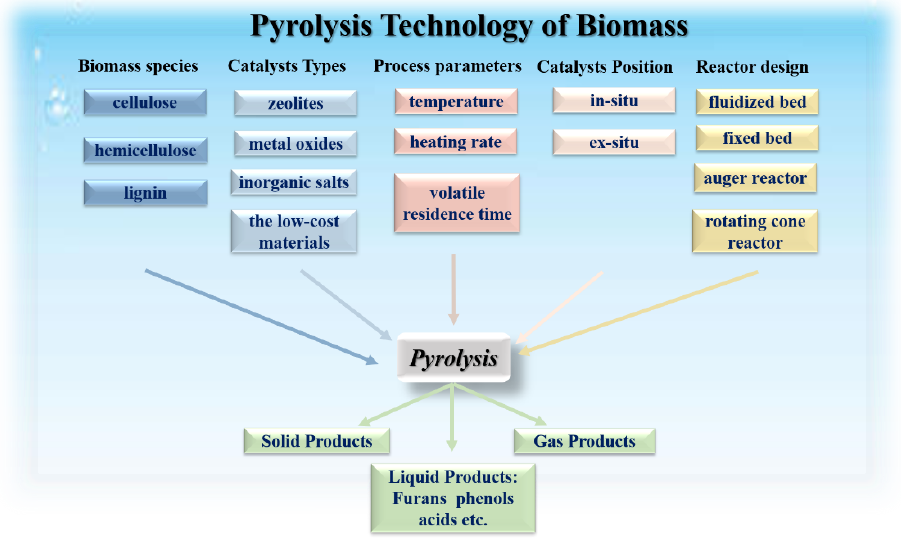
Figure 6. The factors that affecting the pyrolysis of lignocellulosic biomass.